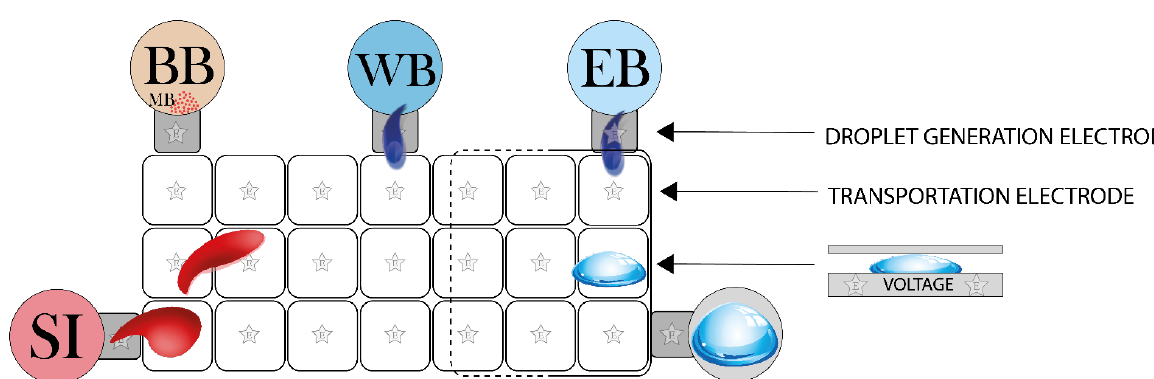
Figure 3. Schematization of a DMF platform. Droplets are formed from the reservoirs (e.g., SI = Sample Inlet, BB = Binding Buffer, WB = Washing Buffer, EB = Elution Buffer) by droplet generation electrodes. Each droplet is controlled in its path by voltage application on all the transportation electrodes.